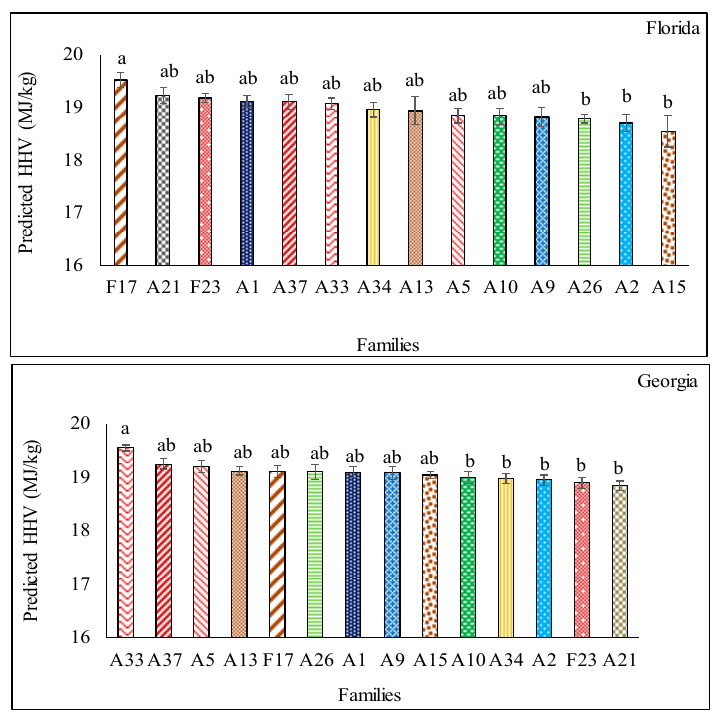
Figure 5. Rank of loblolly pine families for energy content. * Bars with different letters are significantly different at 95% confidence level (Tukey’s HSD Test).